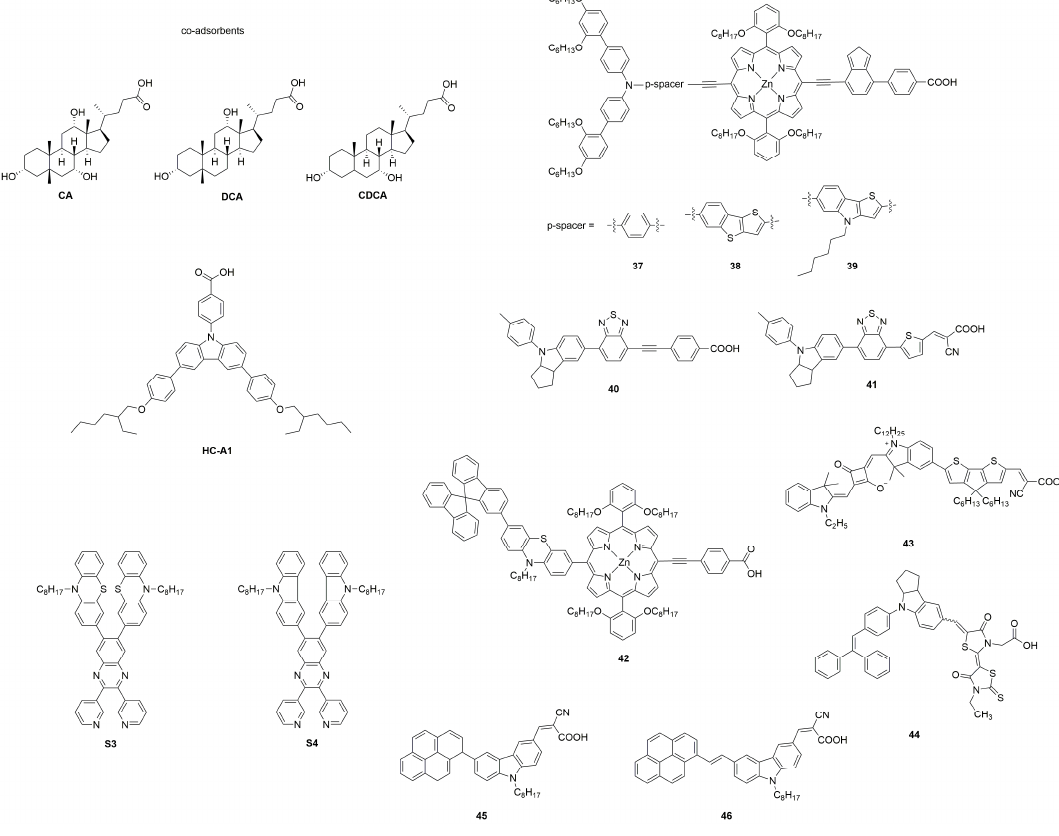
Figure 9. Chemical structures of co-adsorbents and dyes 37 – 46 .